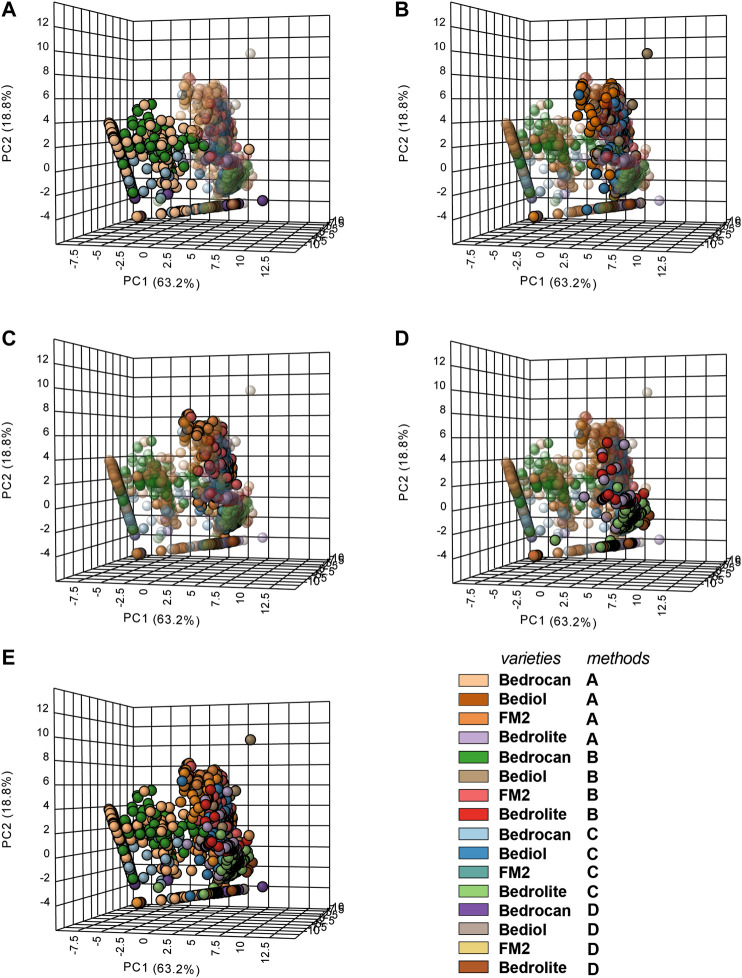
3D Principal component analysis (PCA) plot of cannabis oil extracts divided into groups according to the plant varieties and extraction method (4,774). In the panel, the plant varieties are evidenced, whereas the extraction adopted was color coded (according to the legend). In the panel, (A) Bedrocan, (B) Bediol, (C) FM2, (D) Bedrolite, and (E) the entire data set overview are evidenced. For details on preparation methods, see the following references: Method A (Romano and Hazekamp, 2013), Method B (Citti et al., 2016), Method C [Società Italiana Farmacisti Preparatori (SIFAP), 2016; Casiraghi et al., 2018], and Method D (Calvi et al., 2018).